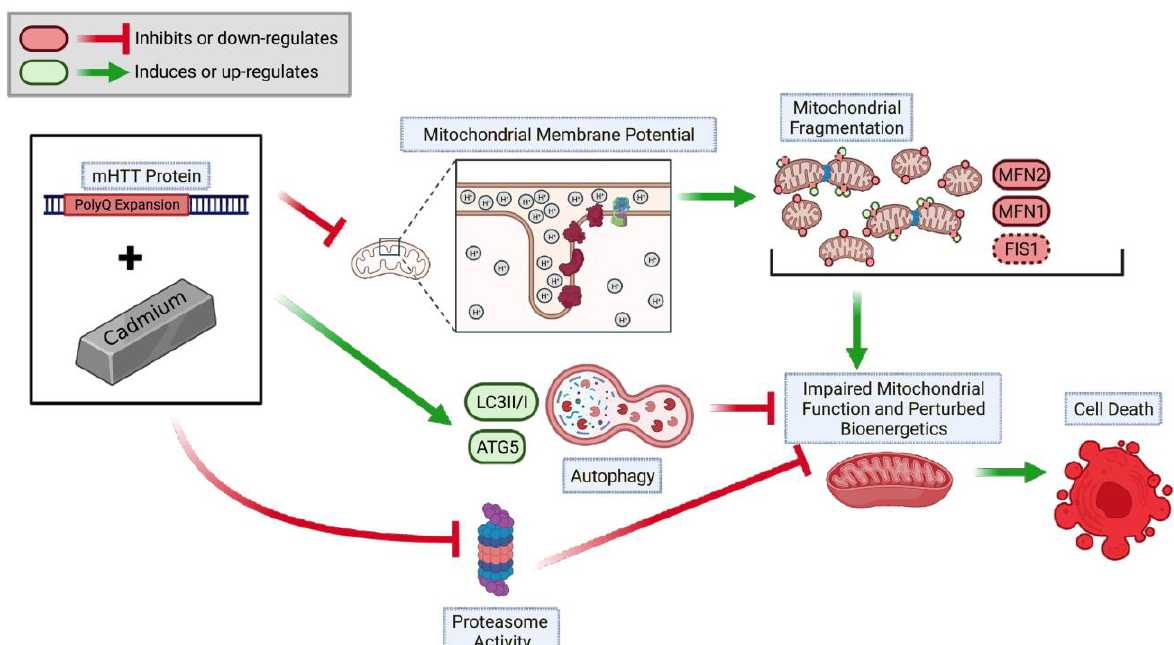
Figure 7. A proposed model describing the pathogenic sequence of cell death signaling events in Cd-triggered deficits in mitochondrial health and function and protein degradation pathways. HD cells at baseline exhibit reduced mitochondrial biogenesis. HD cells, in tandem with Cd exposure, exacerbate perturbations in MMP, inhibit proteasomal activity, and augment autophagic pathways. Prolonged maintenance of these pathogenic mechanisms leads to defective mitochondrial function-mediated cell death.